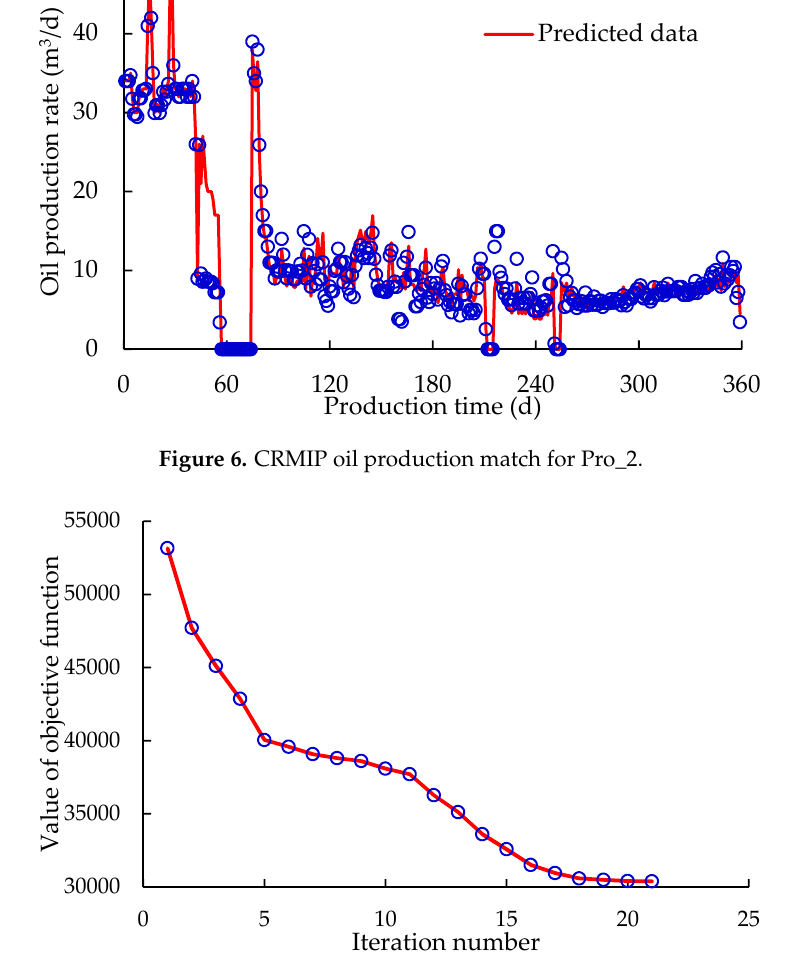
Figure 7. Iteration procedure of objective function based on the CRM–Koval model. Table 1. The estimated control variables of CRMIP–Koval model.